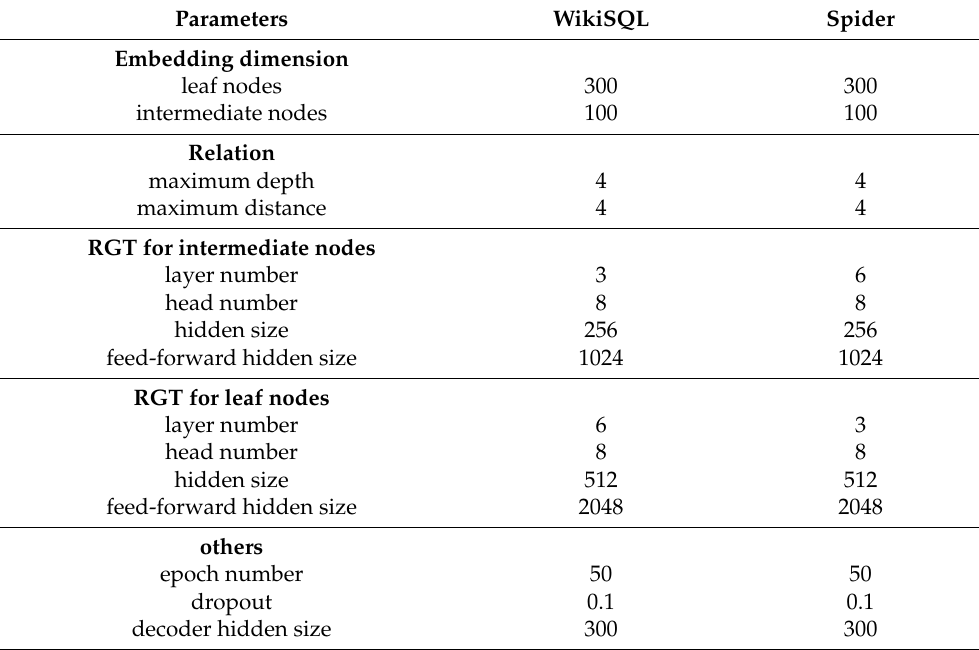
Table 4. Hyper parameters for our model on WikiSQL and